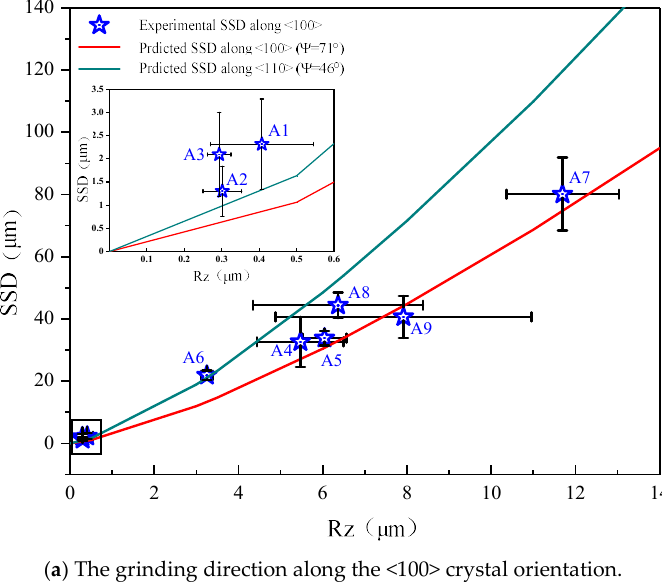
Figure 7. The morphology of subsurface in ground optical samples.